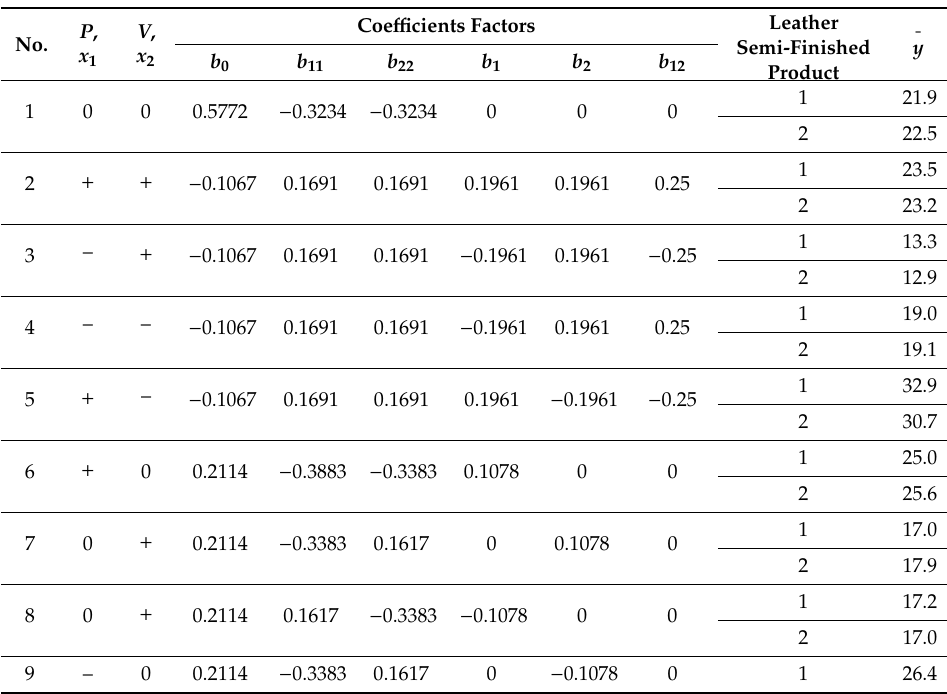
Table 8. Coe ffi cient